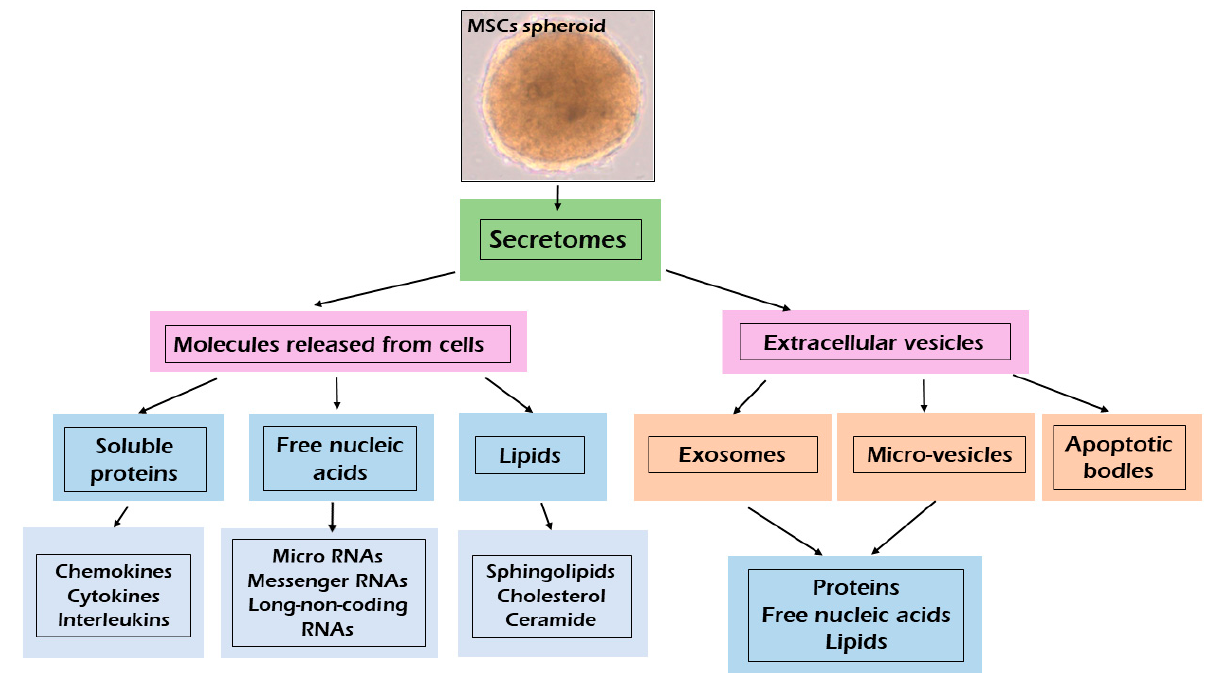
Figure 1. Composition of bioactive factors release by mesenchymal stem cells.